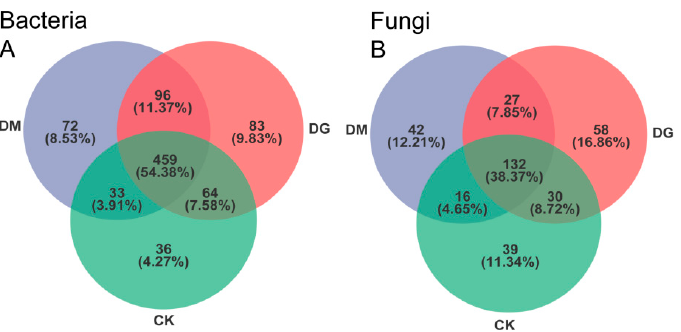
Figure 4. Venn diagrams of bacteria ( A ) and fungi ( B ) from different soil types at the genus level in the soil.